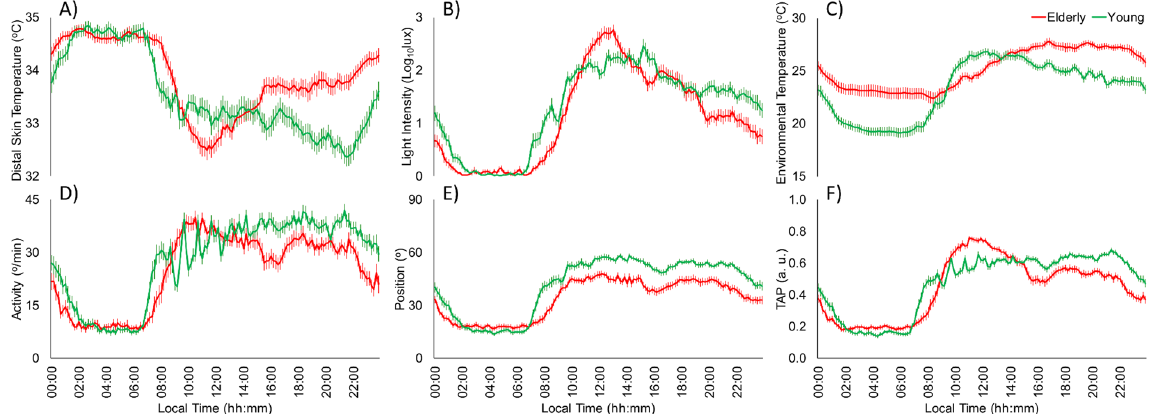
Figure 1. Mean-waveforms for young (green line, n: 44) and aged participants (red line, n: 44) for: ( A ) distal skin temperature, ( B ) light exposure, ( C ) environmental temperature, ( D ) activity, ( E ) body position and ( F ) the integrated variable TAP. All variables are expressed as the mean ± SEM.